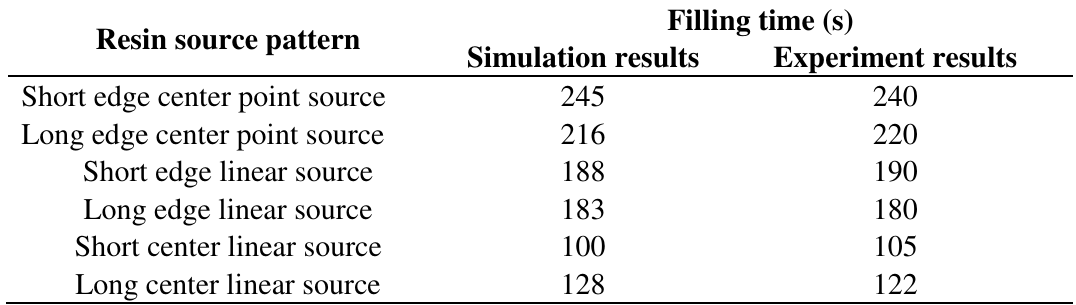
Table 3. Influence of resin source pattern on filling time in the VARI process.